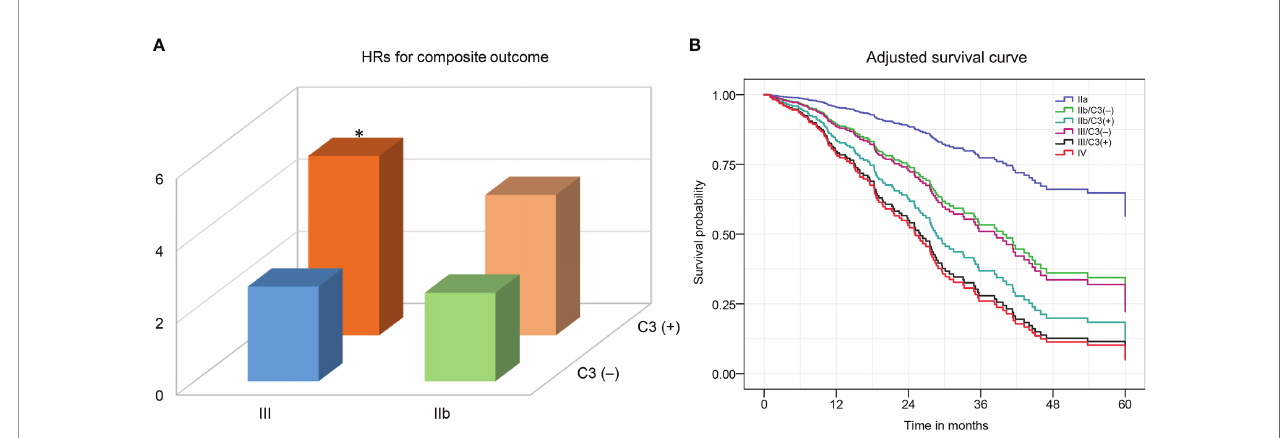
FIGURE 3 | The hazard ratios (A) and adjusted-cumulative survival curve (B) for a composite of ESRD, ≥ 50% decline in initial eGFR, or death according to the combination of C3 deposits and the 2010 RPS DN classi fi cation. The Cox proportional hazards model was adjusted for age, sex, duration of diabetes, diabetic retinopathy, serum albumin, proteinuria, eGFR, and ACEI/ARB treatment. ESRD, end-stage renal disease; eGFR, estimated glomerular fi ltration rate. RPS, Renal Pathology Society; DN, diabetic nephropathy. * p < 0.05 vs. class III/C3( – ).